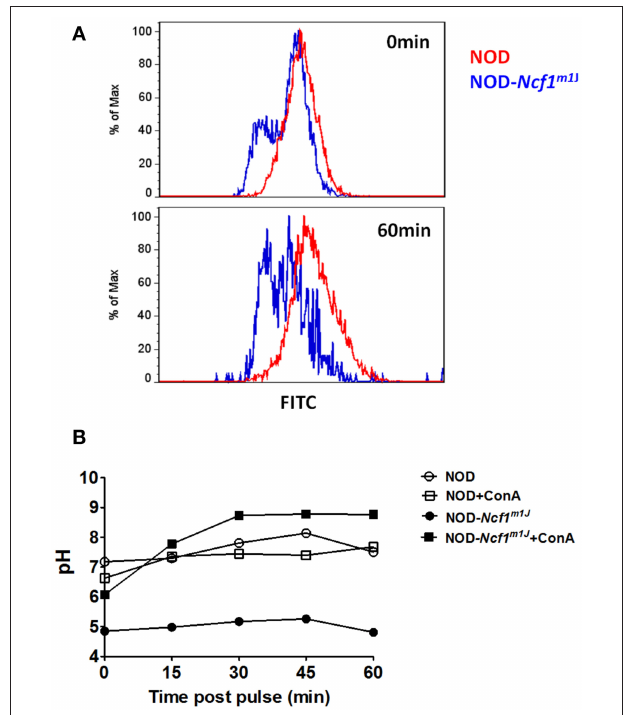
FIGURE 4 | Enhanced phagosomal acidification in NOD- Ncf1 m1J DCs. (A) Representative histogram of DCs phagocytized FITC/AF647 linked beads. DCs from NOD or NOD- Ncf1 m1J were incubated with fluorescence linked latex beads for 15min, then unbound beads were washed away. Cells were cultured 0, 15, 30, 45, or 60 additional minutes then cells were analyzed by FACS. (B) Phagosomal pH kinetics of DC from NOD or NOD- Ncf1 m1J